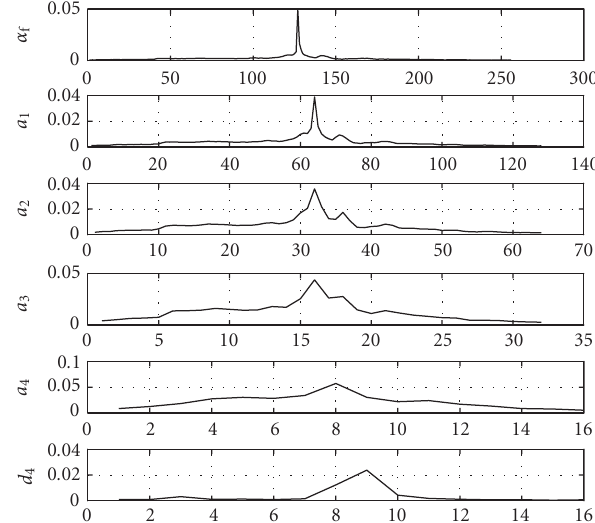
Figure 7: The part of the tree of variances of α f [ n ], as defined in the scheme. The figure starts with the original variance signal. The second plot is h , the third is hh , the fourth is hhh , the fifth is hhhh , and the last one is hhhg